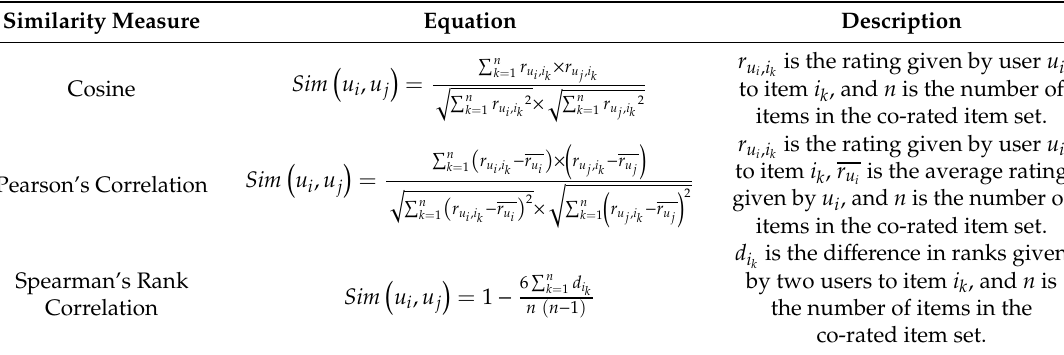
Table 1. Mostly applied similarity measures